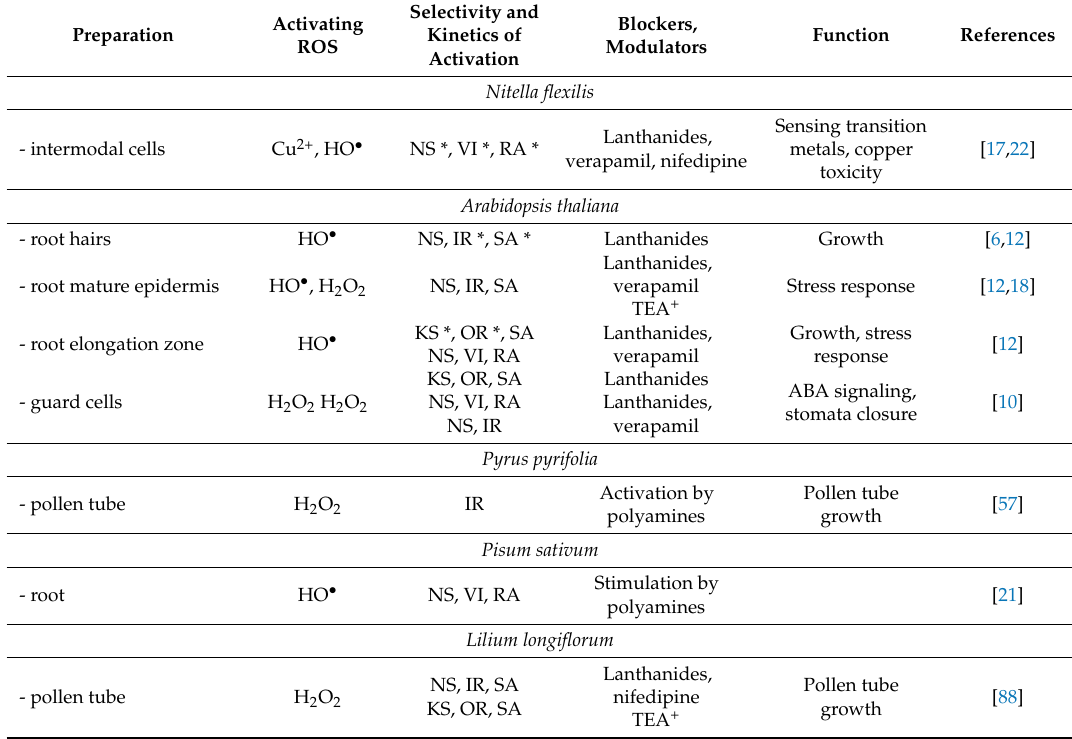
Biophysical and functional characteristics of ROS-activated ion channels in plant plasma